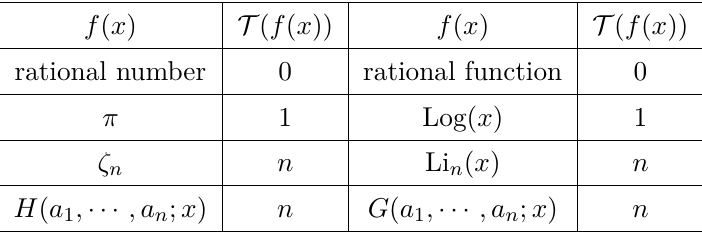
Table 1. Transcendental weight of some